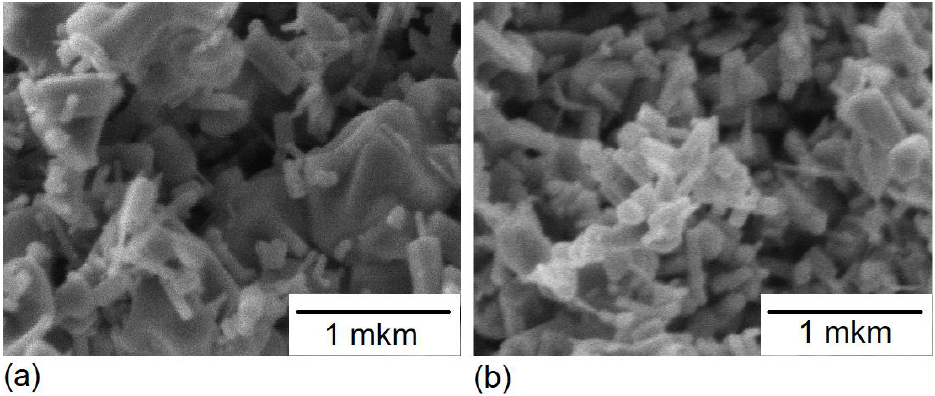
Figure 1. SEM micrographs of ZnO powder: ( a ) commercial and ( b ) mechanically activated for 5 h.